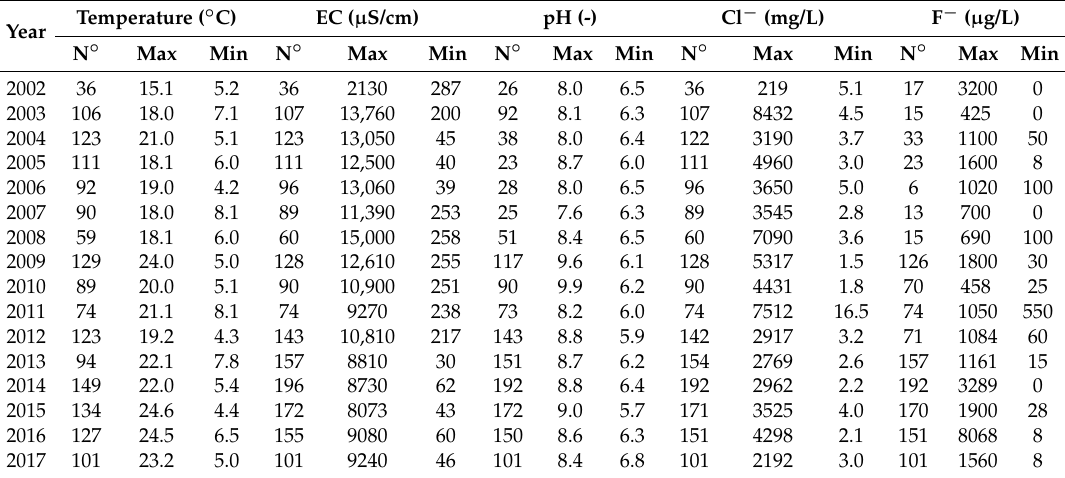
Table 1. Summary of the spring water physiochemical parameters database. N ◦ refers to the number of observations available for the selected